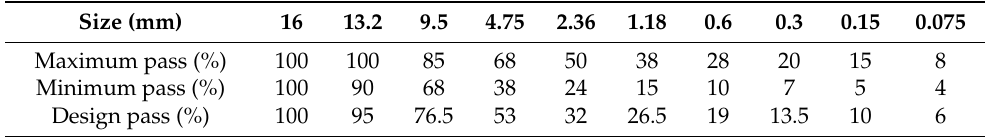
Figure 2. Preparation of PCB non-metallic powder and SBR (PS) modified bitumen.